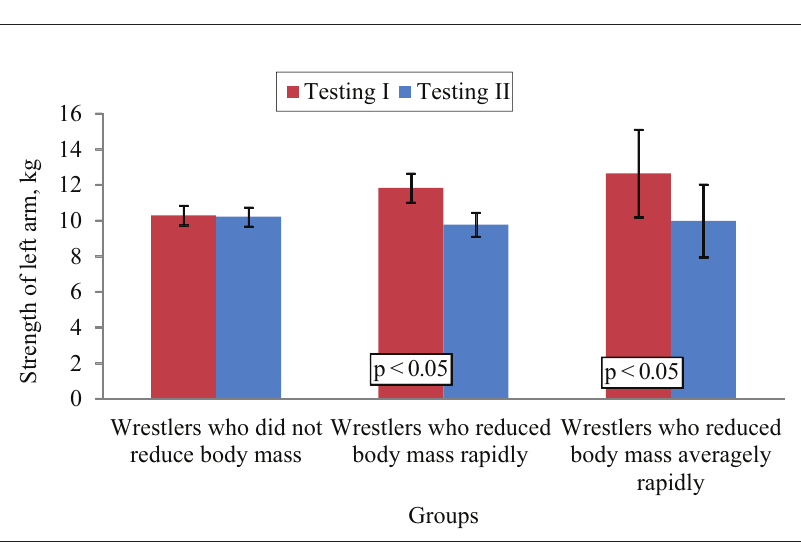
Figure 5. Wrestlers’ left arm force changes